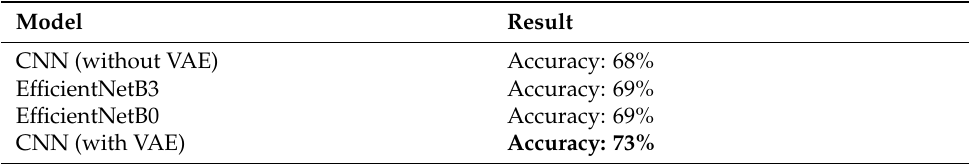
Table 4. Comparative analysis between classification results from different implementations including our best result. The best result is highlighted in